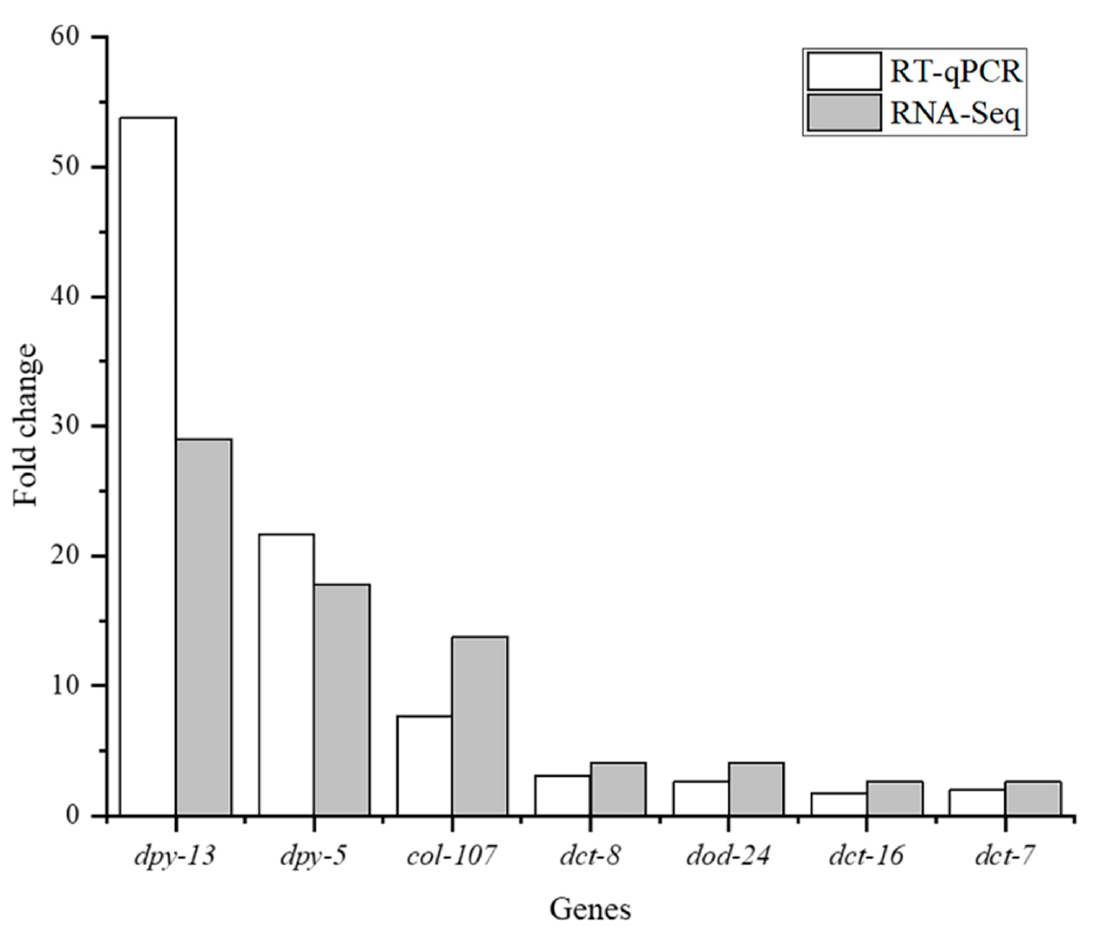
Figure 4. Validation of RNA-Seq data through RT–qPCR analysis of selected genes in C. elegans treated with QBLP for 14 days. Relative mRNA expression (calculated based on 2 − ∆∆ CT ) of dpy-13 , dpy-5 , col-107 , dct-8 , dod-24 , dct-16 , and dct-7 , with β -actin as the reference gene.